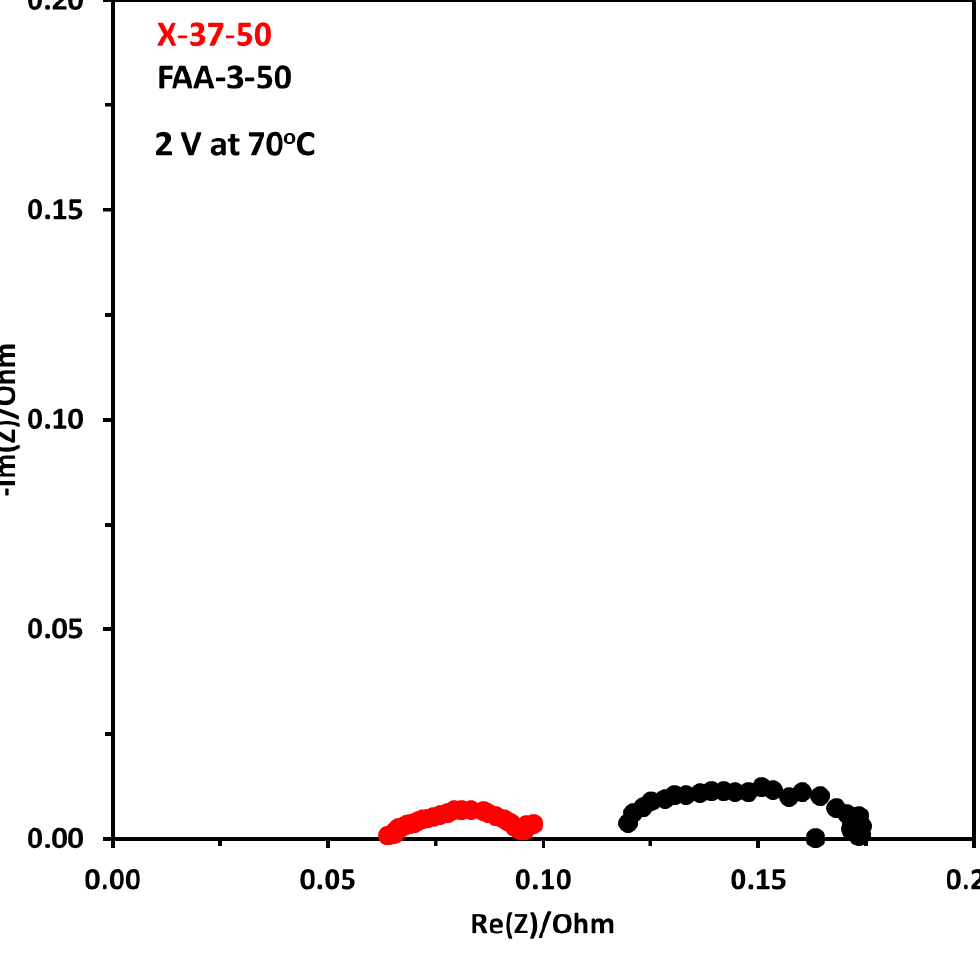
Figure 14. Nyquist plot at constant voltage of 2 V at 70 ◦ C with FAA-3-50 and X-37-50 anion exchange membranes, the concentration of electrolyte was 1 M. Pt/C was used at the cathode and NiFeCoO x was used at anode.